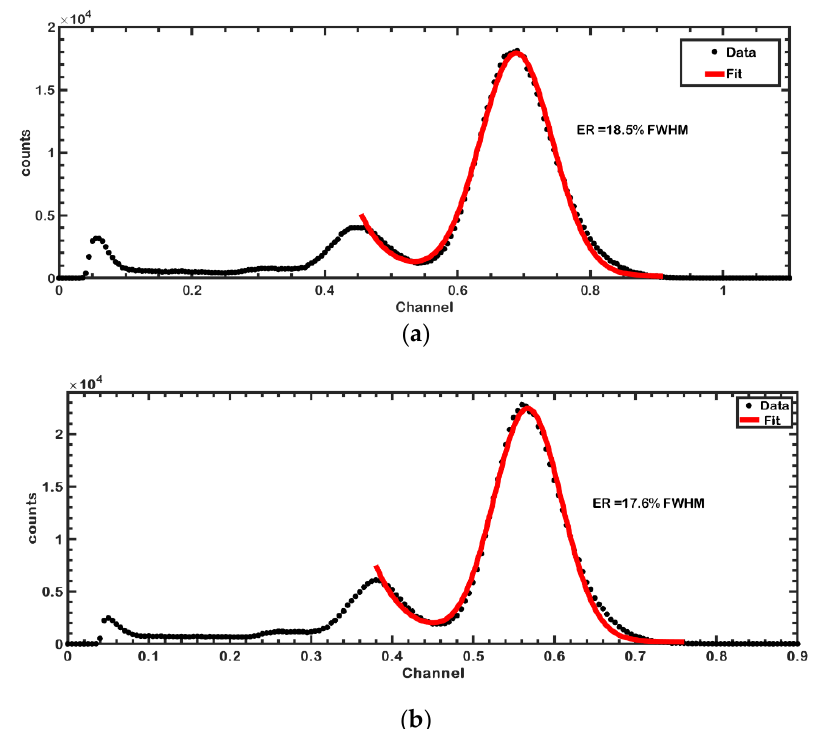
Figure 5. Energy spectra acquired using the Co-57 radiation source with the proposed gamma probe. ( a ) Energy spectrum and resolution (18.5%) acquired from the standalone gamma probe without using the integrated US-gamma probe front-end circuit (setup S1). ( b ) Energy spectrum and resolution (17.6%) when the proposed front-end integrated US-gamma probe circuit was used (setup S2).